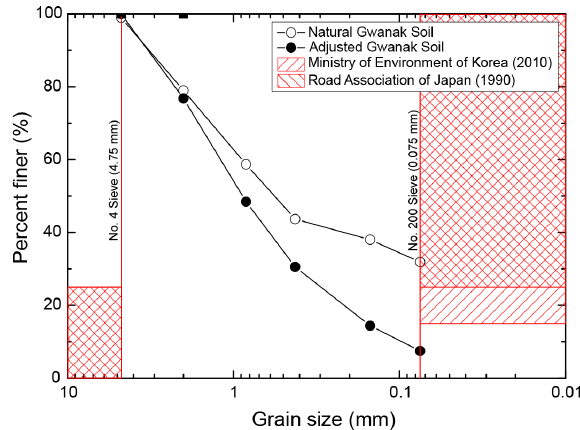
Figure 2. Grain distribution of the natural Gwanak soil and the Gwanak soil adjusted as per the requirements for backfill materi- als in South Korea (Ministry of Environment of Korea, 2010) and Japan (Japan Road Association,